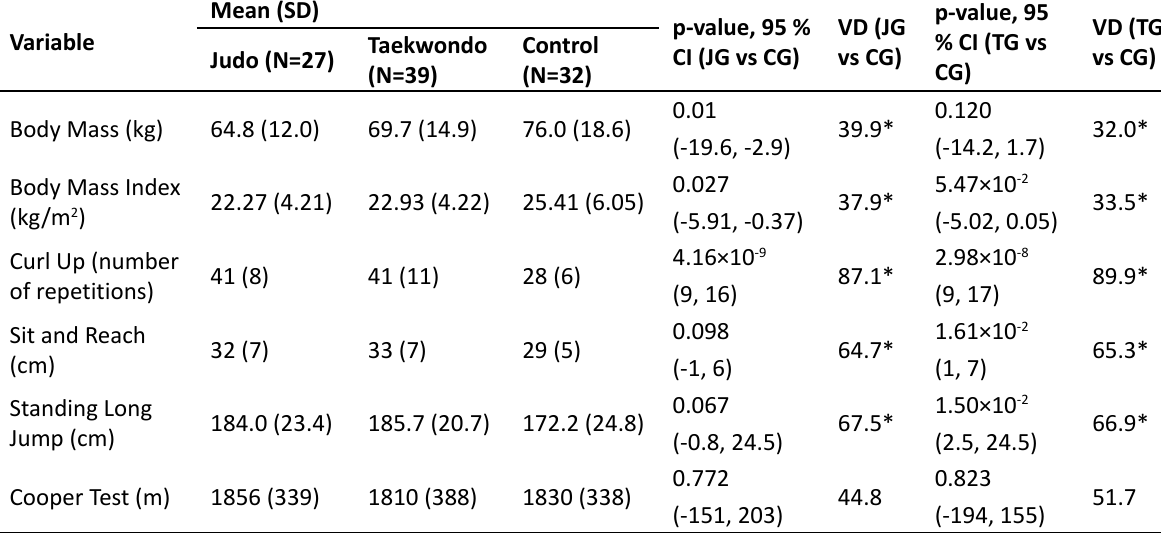
Table 1. Differences in baseline data of exercise groups to control group